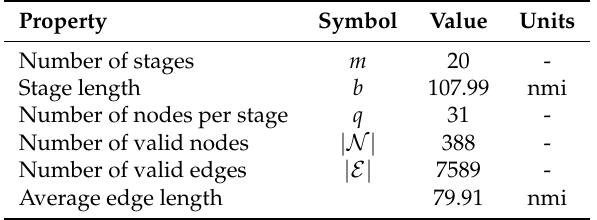
Table 3. Navigation graph main properties and associated values for the selected scenario.